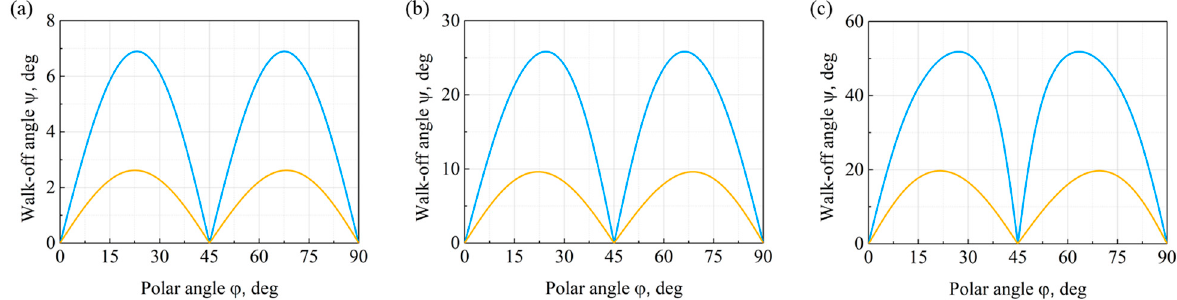
Figure 6. Distribution of acoustic energy walk-off angles in the XY plane of a phononic crystal with a normalized hole diameter: ( a ) d/a = 0.4; ( b ) d/a = 0.6; and ( c ) d/a = 0.8. Table 2. Maximum values of the energy walk-off angles of acoustic modes in phononic crystals with various normalized hole diameters.